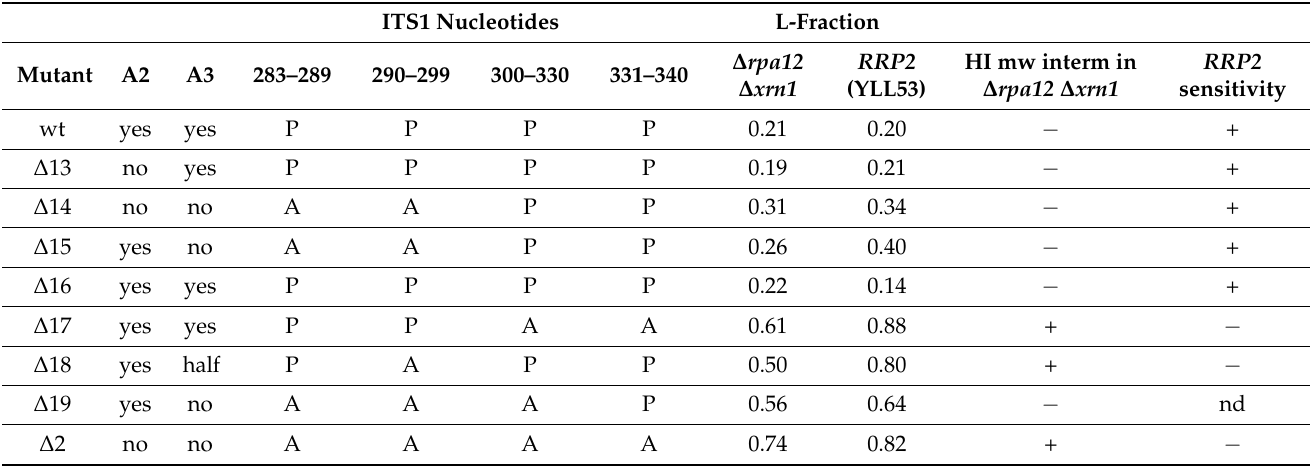
Table 3. Summary of characteristics of ITS1